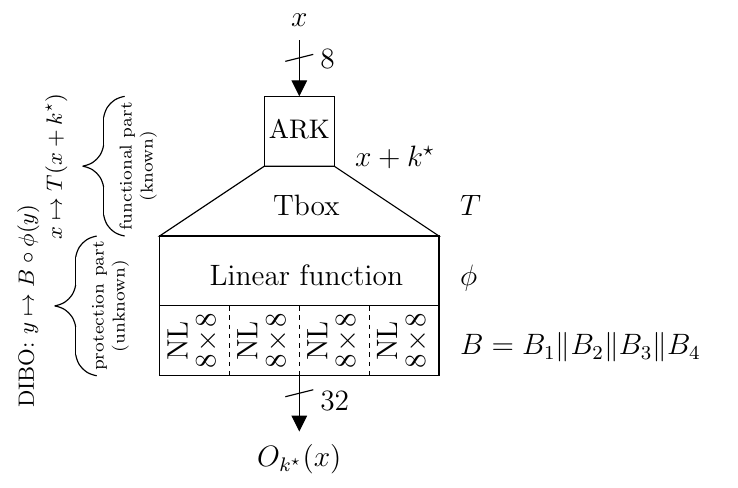
Figure 1: White-box protection O k ? (equation (2)) of x ∈ F 8 is known but k ? is one byte of the secret key), with DIBO function B ◦ φ (i.e., the internal encoding). Notice that “NL” stands for the non-linear B i , for 1 ≤ i ≤